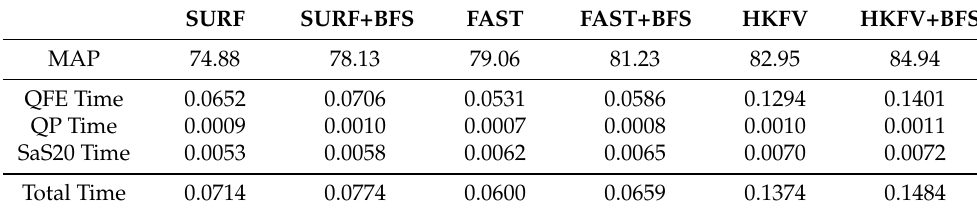
Table 3. Comparison validate the effectiveness of each component in the framework.